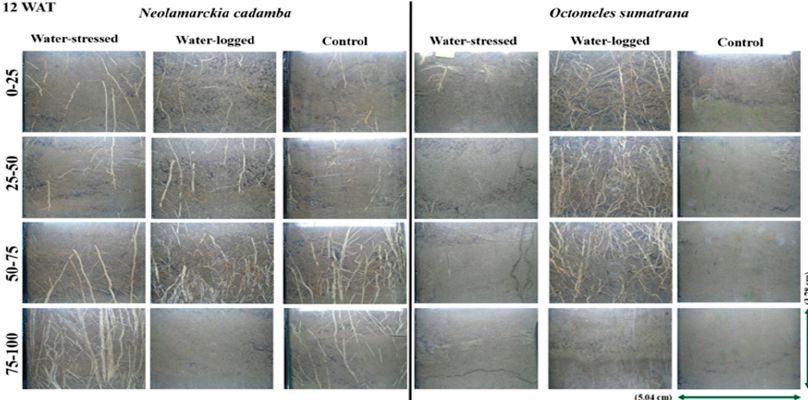
Figure 2. Root images of samples from the second harvesting stage (12 WAT). Roots were directly visualized, and images were measured (each image is 37.8 mm × 50.4